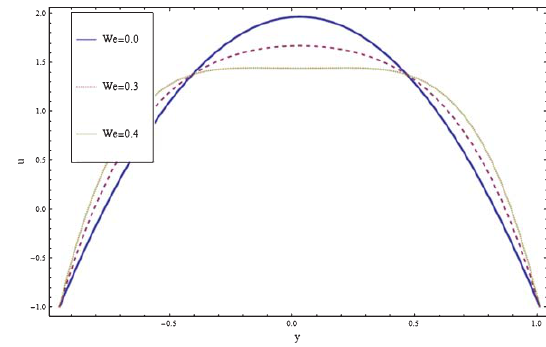
Fig. 2. Plot showing u versus y . Here a = 0 . 6, b = 0 . 3, d = 1 . 1, (cid:14) = 4, φ = π/ 6, x = 0 . 25 and n = 0 . 398.